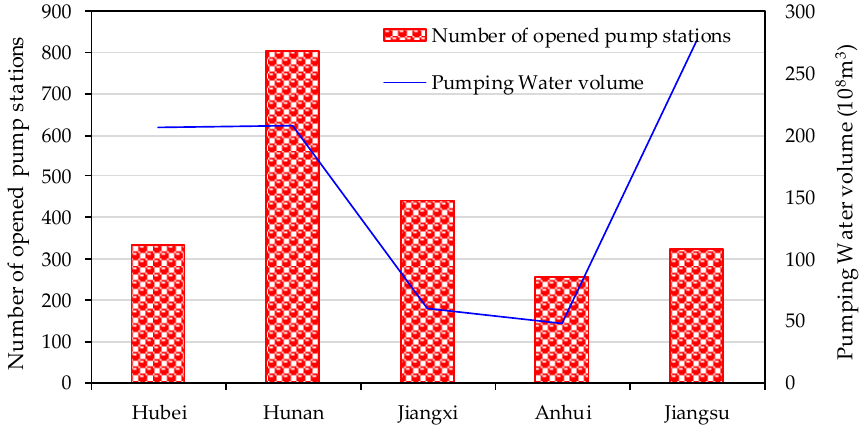
Figure 6. Flood drainage of the middle and lower Yangtze River in the 2020 flood season.